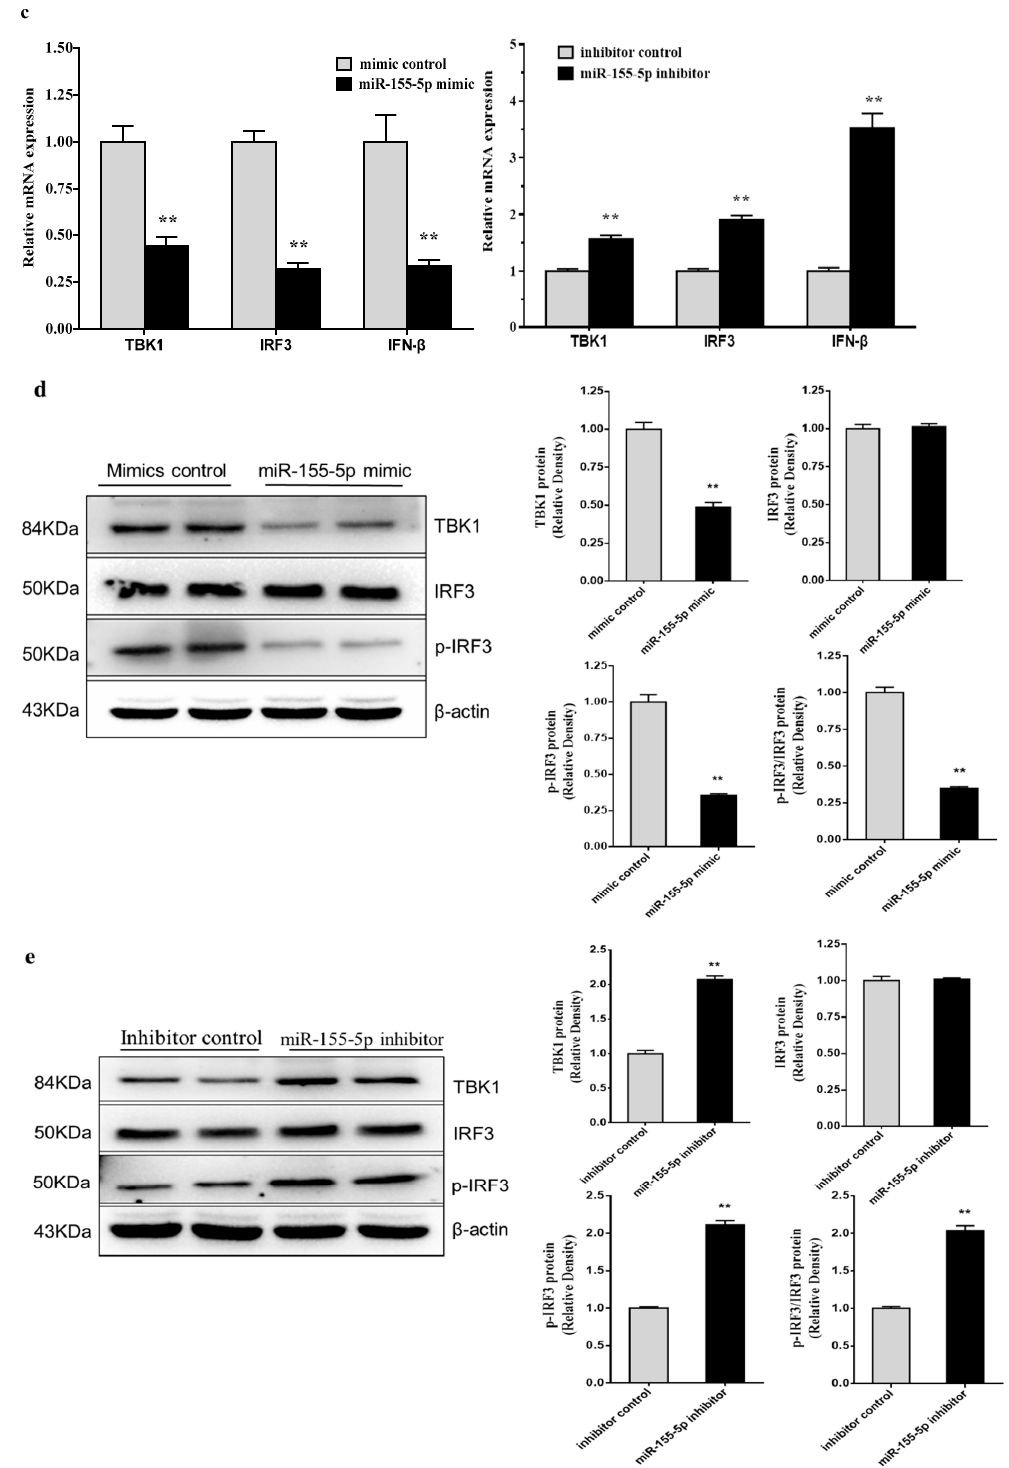
Figure 4. This miR-155-5p is involved in RV infection process. Cells were transfected with miR-155-5p mimic or inhibitor, and then infected with RV at a MOI of 10 for 1 h. The miR-155-5p expression ( a ), RV ( b ), TBK1, IRF3, and IFN- β mRNA levels ( c ) were measured by real-time quantitative PCR. The TBK1, IRF3 and p-IRF3 protein levels in the IPEC-J2 cells treated with miR-155-5p mimic ( d ) or inhibitor ( e ) were measured by western blot. All data were expressed as means ± SD (bars represent the SD from three independent experiments). ** p <